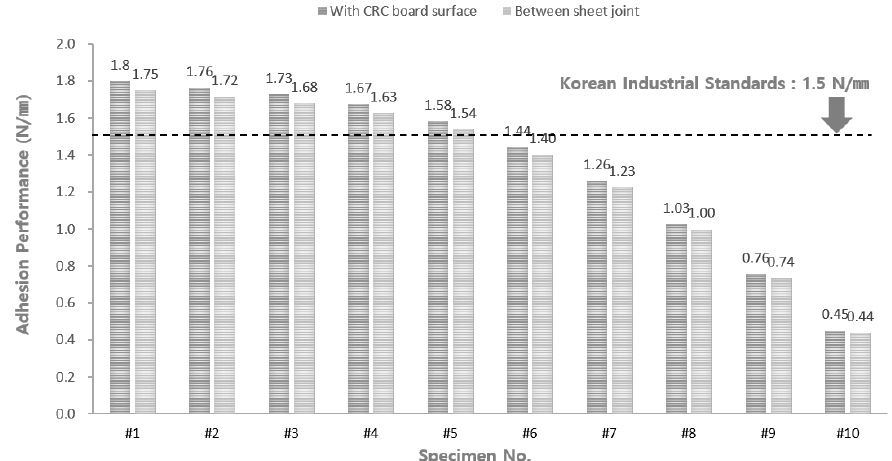
Figure 10. Adhesion performance test result of the H 2 SO 4 -treated sample.